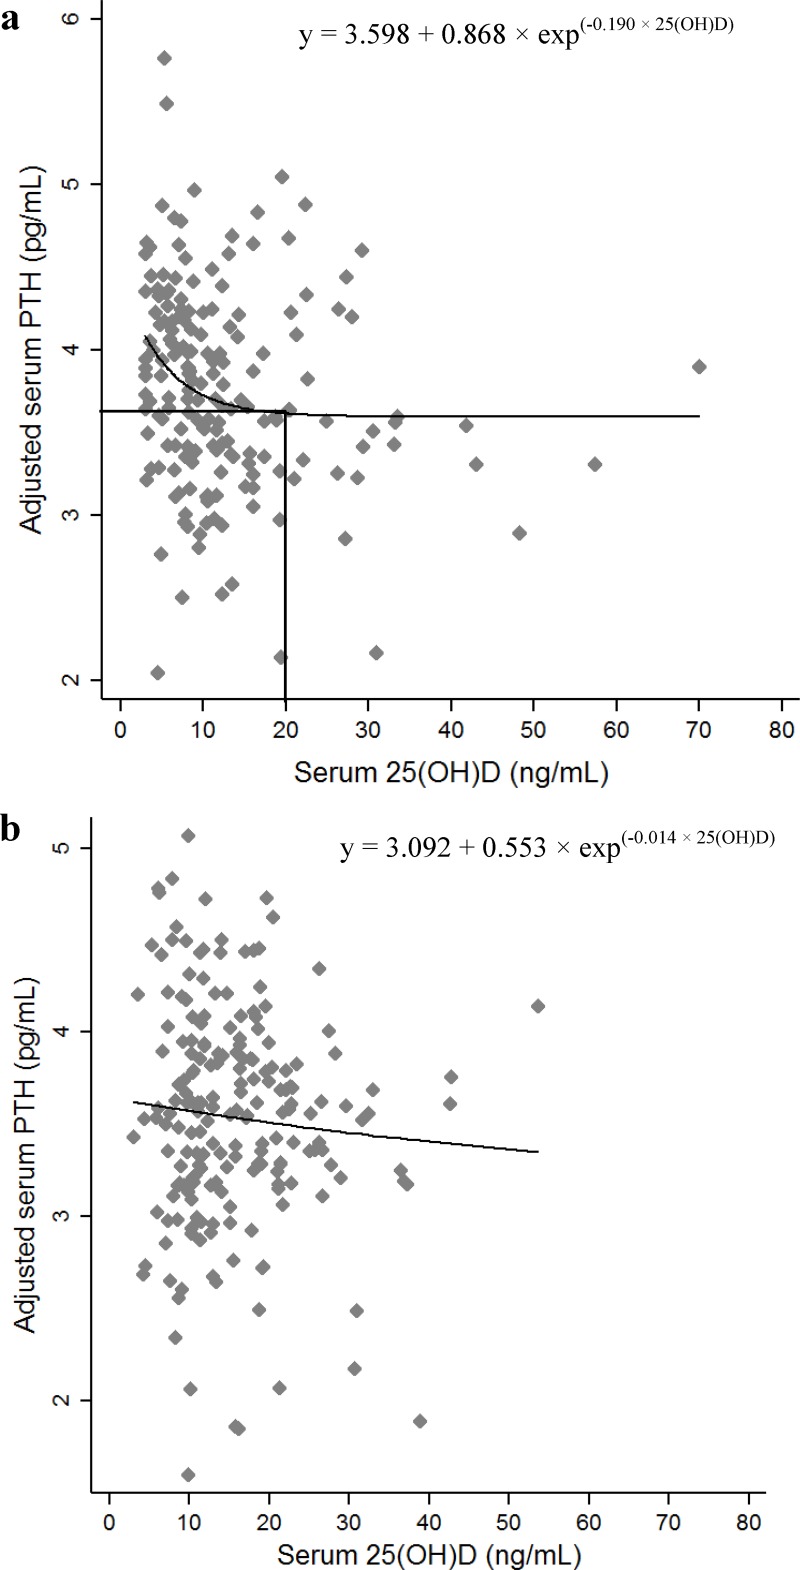
Association between serum 25(OH)D and adjusted log-transformed iPTH concentrations using nonlinear regression analysis.(a) females; (b) males.